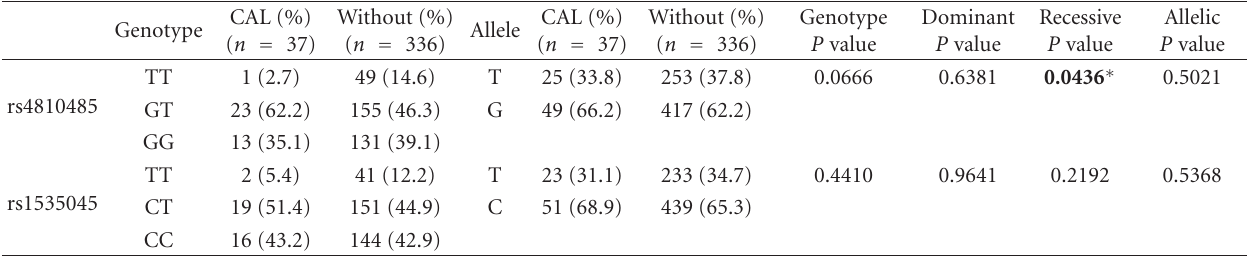
Table 3: Genotype and allele frequencies of the CD40 gene in patients with or without coronary artery lesion (CAL) formation. Genotype